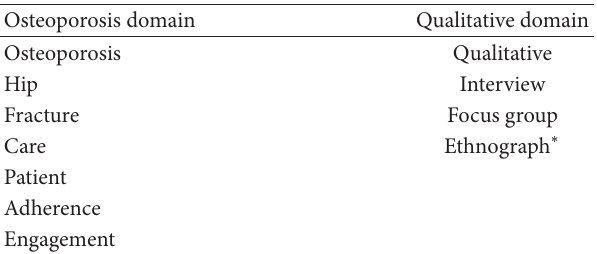
Table 1: The search domains and associated terms used to conduct the narrative